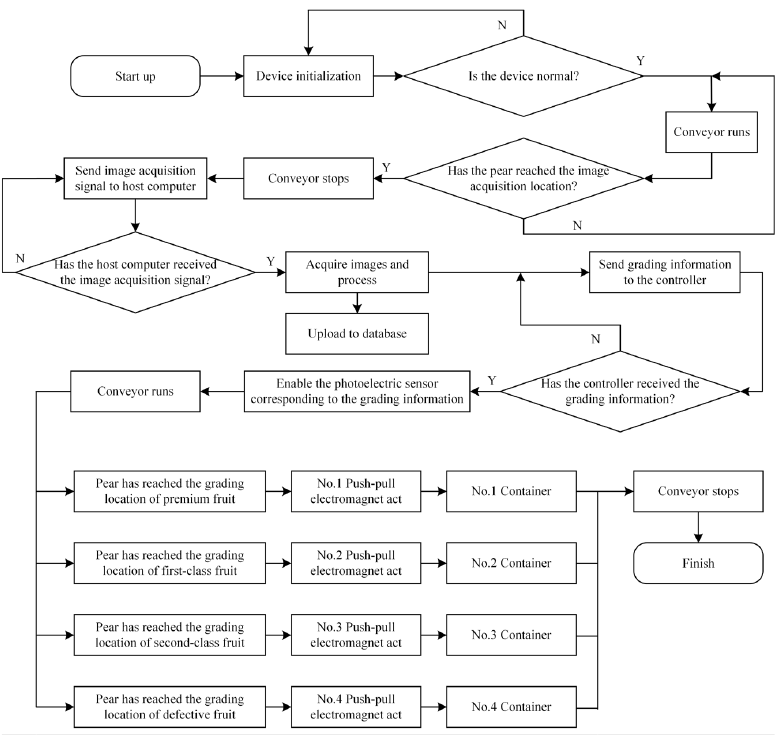
Figure 11. Schematic diagram of push-pull electromagnet sorting control.